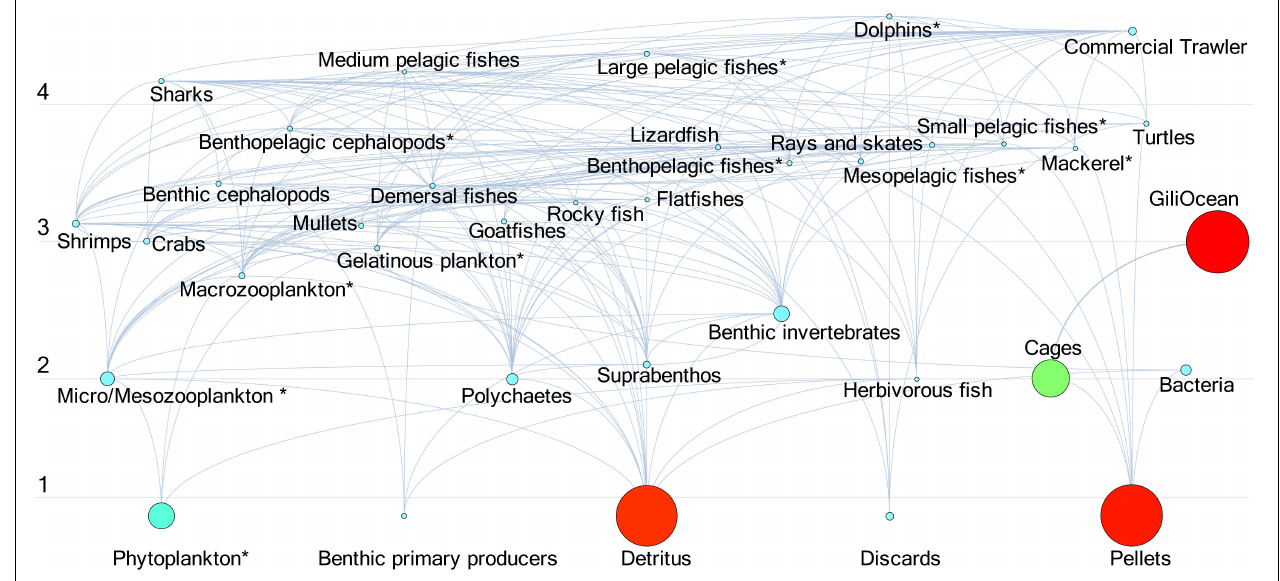
FIGURE 1 | Flow diagram of 34 functional group biomasses and fisheries fleets (GiliOcean, Commercial Trawler).